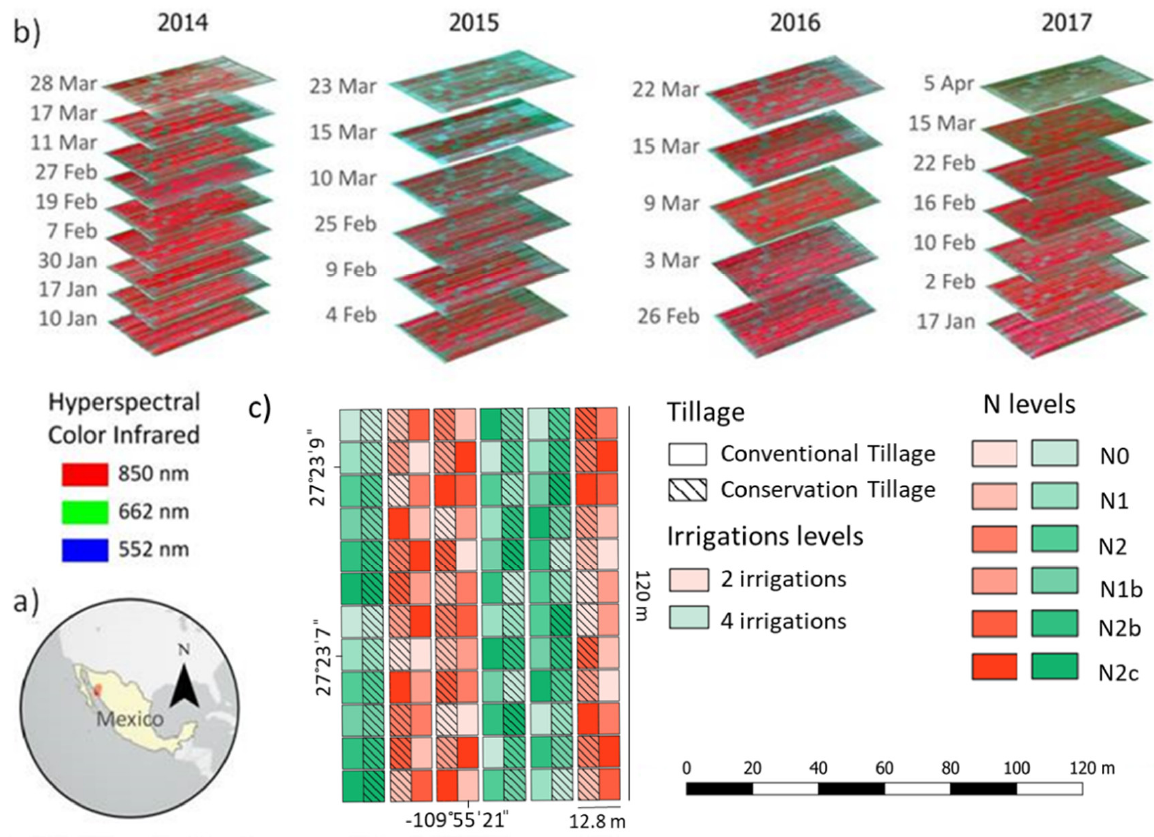
Figure 1. Location of the experiment ( a ), time series images collected across crop cycles and their respective dates ( b ), and experimental factorial design during the 4-year period ( c ).